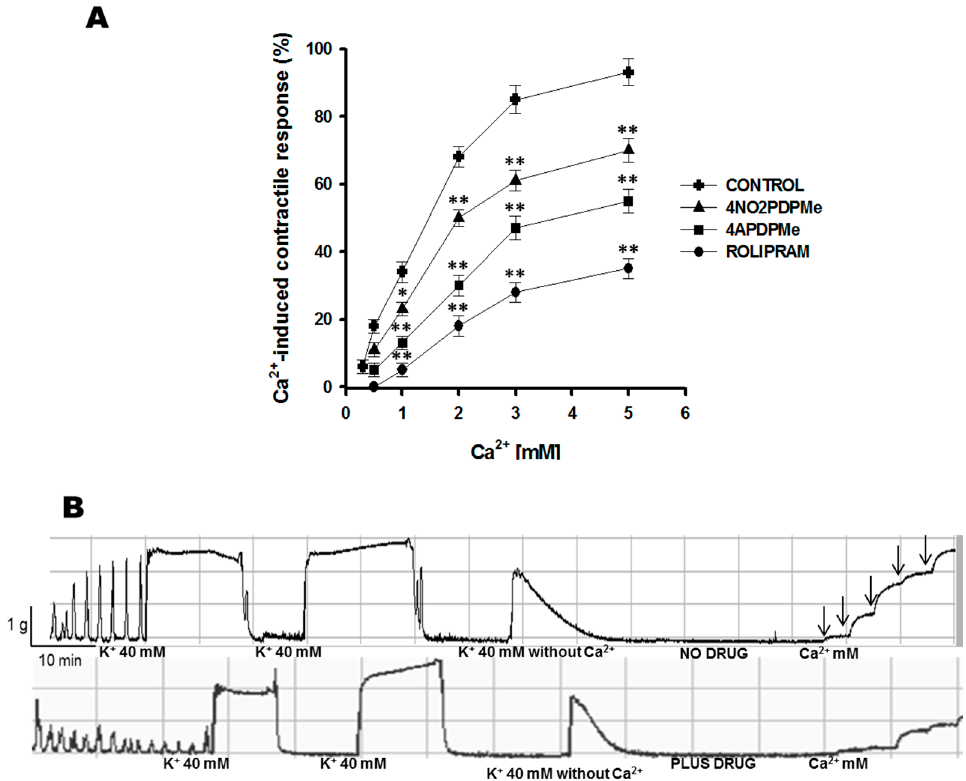
Figure 3. Inhibitory effects of rolipram and thalidomide analogs on Ca 2+ -induced contractions of pregnant human myometrium. ( A ) Concentration-effect curves of the Ca 2+ -induced tonic contractile response (40 mM KCl) of pregnant human uterine strip preparations in the presence of the respective IC 50 concentrations of rolipram (98.45 µ M), 4APDPMe (125 µ M), and 4NO2PDPMe (203.45 µ M); each point represents the mean of 6 experiments, and vertical bars indicate the standard error of the mean ( ± SEM); ( B ) Typical recording of tonic contractions induced by cumulative Ca 2+ concentrations and inhibited by a thalidomide analog. Difference vs. rolipram, * p < 0.05 or ** p < 0.001.